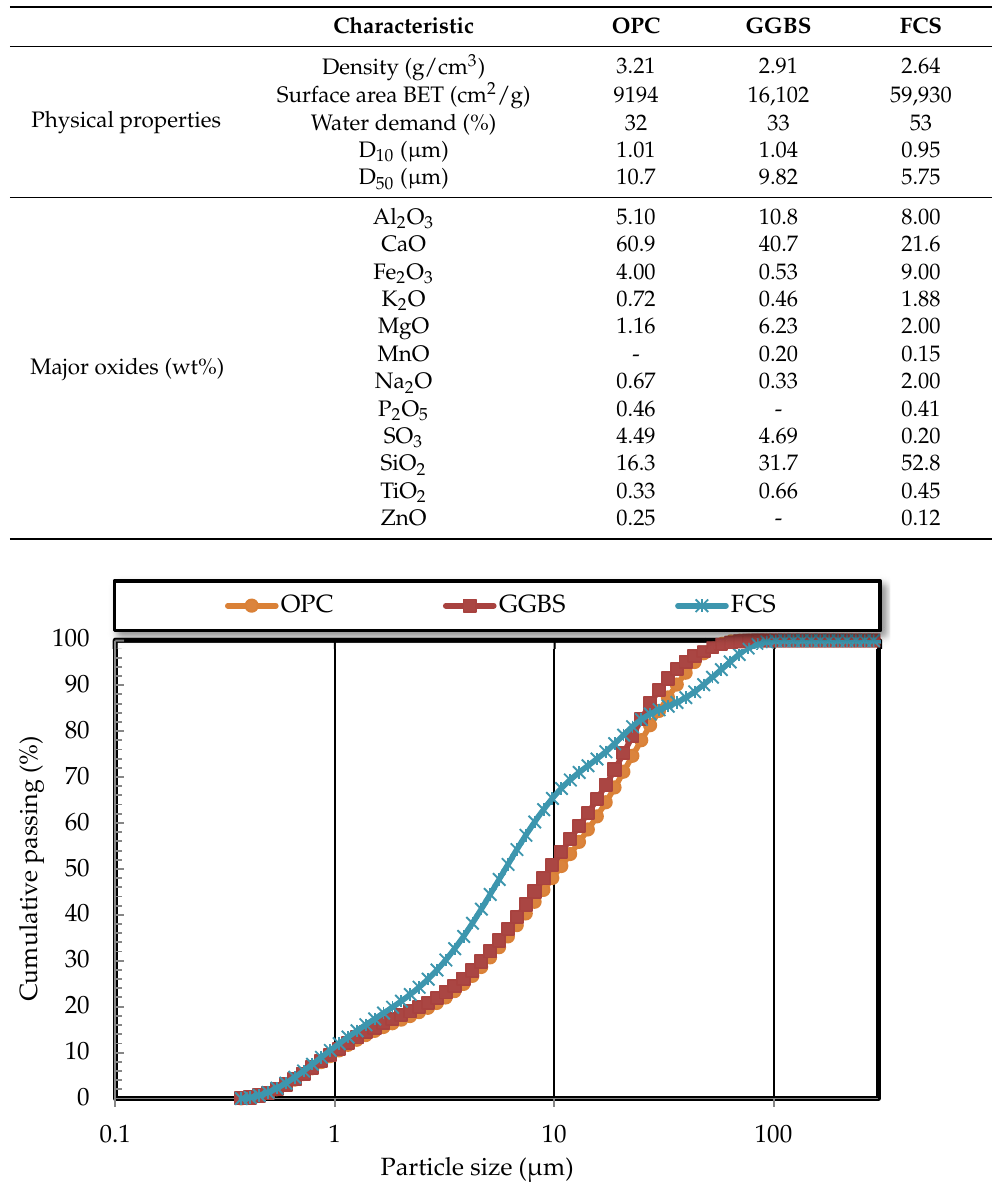
Figure 1. Grain size distribution of OPC, GGBS, and FCS as determined by a laser diffraction